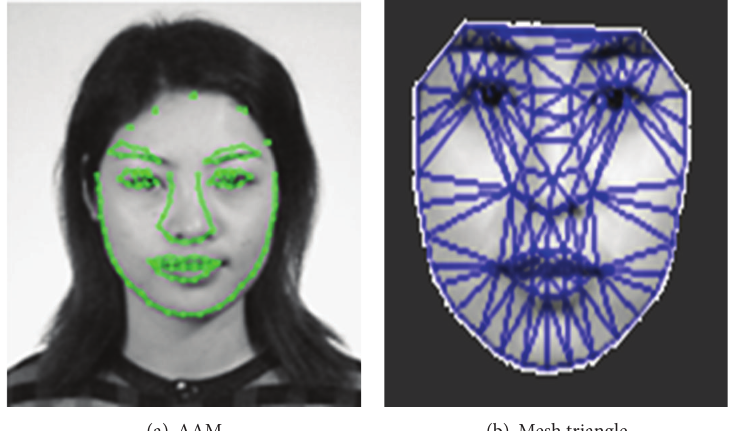
Figure 1: Mesh model of neutral expression.